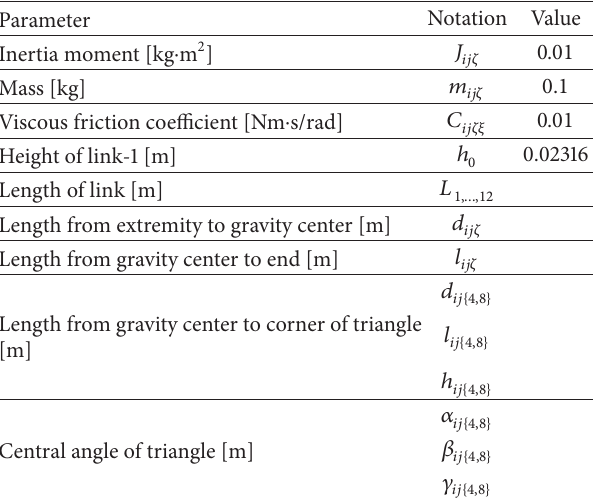
Figure2:SchematicdiagramoftheTheoJansenlinkagemechanism with all parameters defined. The solid lines 𝑙 𝑖𝑗1 , 𝑙 𝑖𝑗2 , 𝑙 𝑖𝑗3 , 𝑙 𝑖𝑗5 , 𝑙 𝑖𝑗6 , 𝑙 𝑖𝑗7 are the links; the two blue triangular parts are treated as the mass components; the dashed lines connect the gravity center of the mass and the corners of the triangle parts. Table 1: Physical parameters of the Theo Jansen linkage mechanism ( 𝜁, 𝜉 = 1,...,8 ).